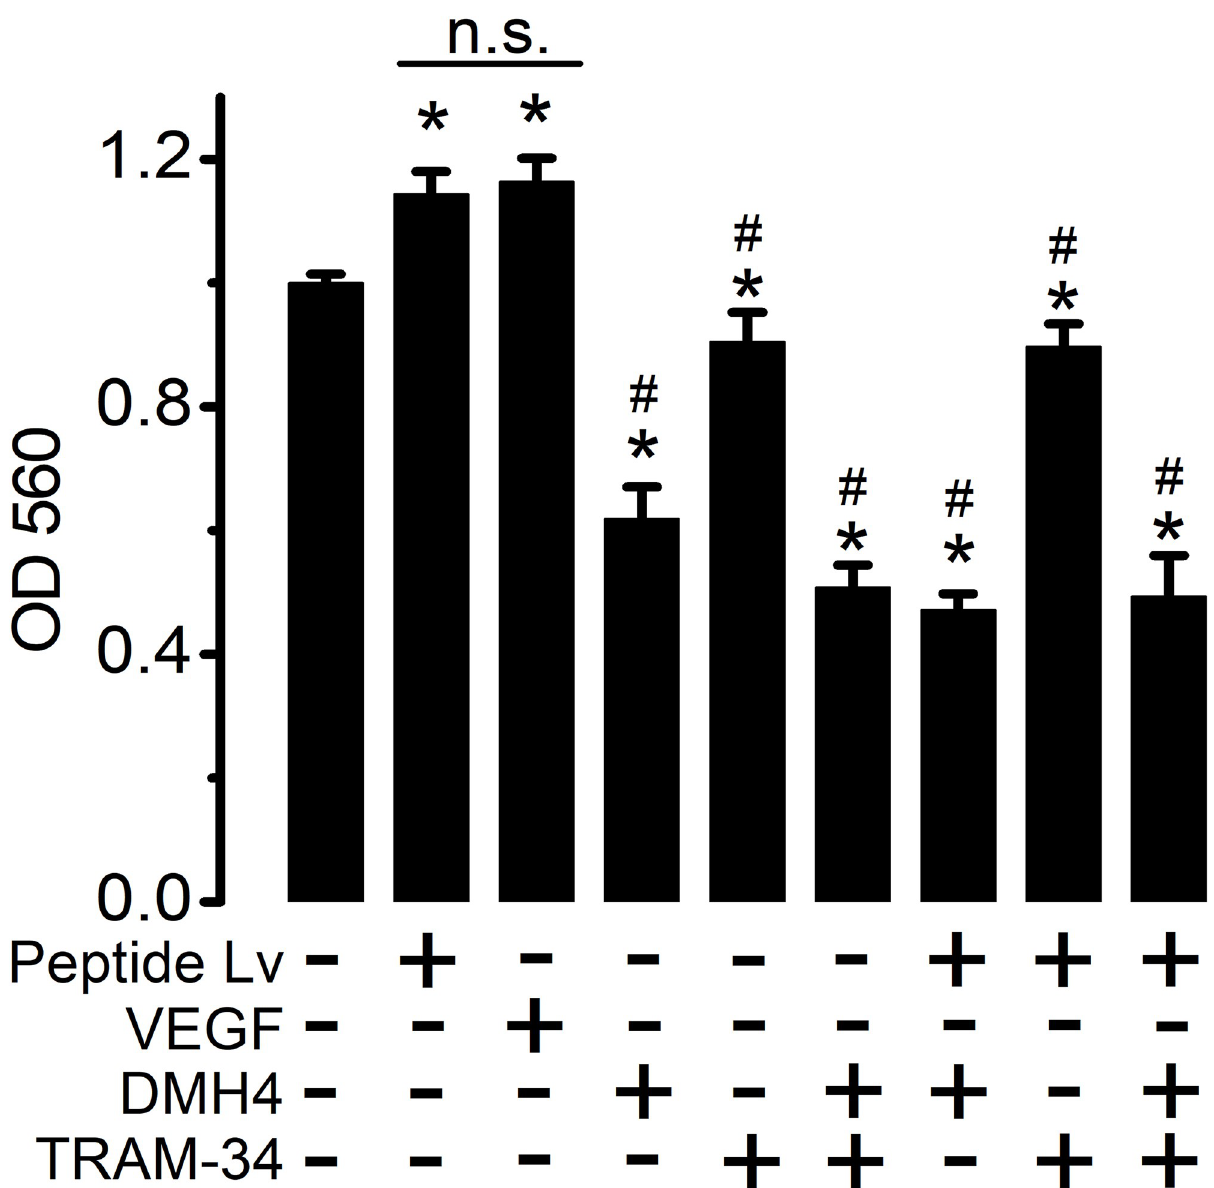
Fig 5. Inhibition of K Ca 3.1 dampens peptide Lv-elicited EC proliferation. HUVECs were treated with peptide Lv (500 ng/ml), DMH4 (5 μ M; a VEGFR2 inhibitor), TRAM-34 (10 μ M, a K Ca 3.1 inhibitor), or a combination of the above for 4 hours. Treatment with VEGF (5 ng/ml) served as a positive control and PBS as the vehicle control. The light absorbance was measured at 560 nm (OD 560 nm) for the MTT proliferation assays. One-way ANOVA followed with Tukey post hoc tests were used for statistical analyses; n = 12–15 for each group; “ � ” denotes a significant difference from the vehicle control; “#” denotes a significant difference from the peptide Lv treated group; p <